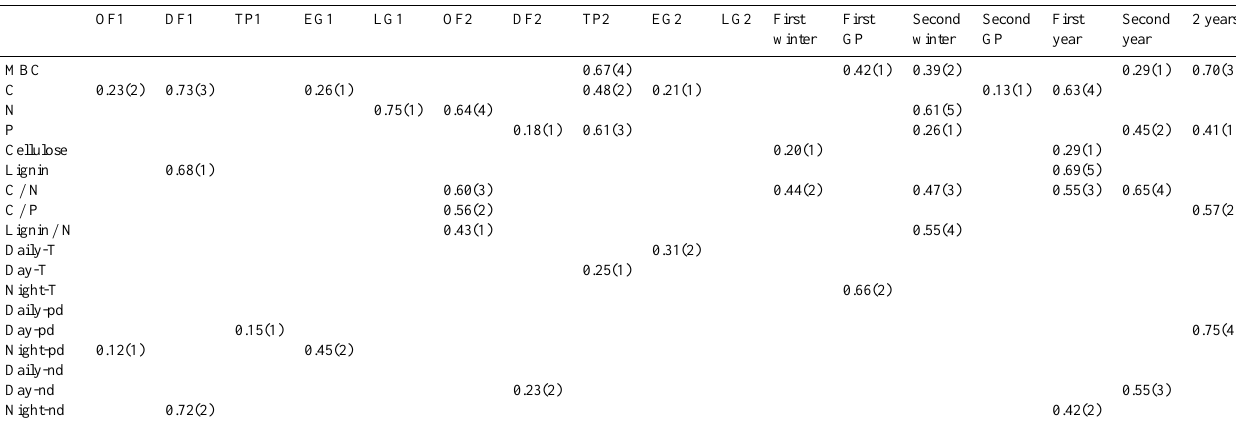
Table 3. Summary tables ( R 2 and step number in brackets; n = 60) of stepwise regression multiple correlations expressed as carbon release rate affected by factors during different foliar litter decomposition